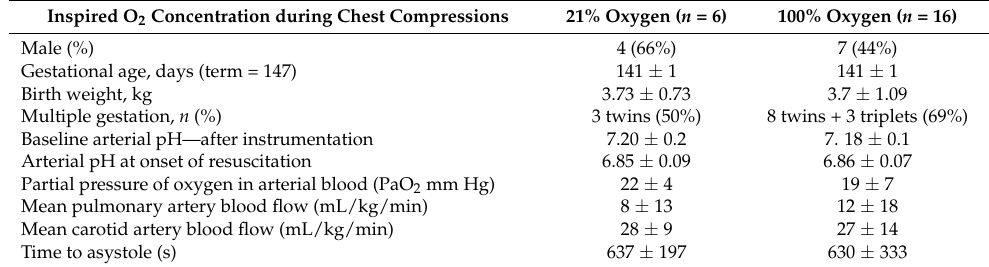
Table 1. Baseline characteristics prior to onset of positive pressure ventilation and chest